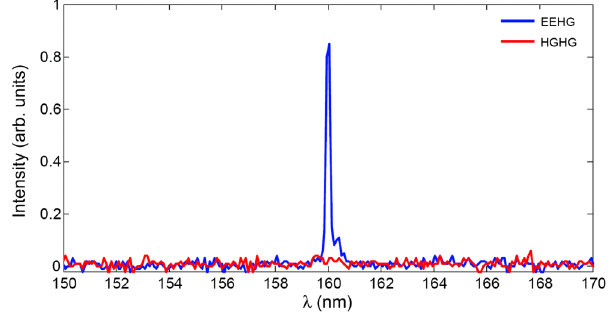
spread increased by a